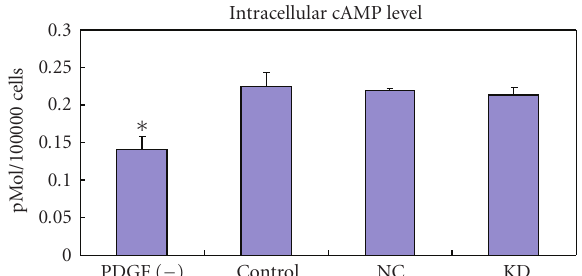
Figure 4: Knockdown of endogenous PDE4D does not a ff ect PDGF-induced cAMP level in VSMC. Bar graph illustrates PDGF- BB induced cAMP level in noninfected cells and cells infected with lentivirus particles carrying either PDE4D or nonsense shRNA. There were no significant di ff erences in cAMP level between cells infected with lentivrius carrying PDE4D shRNA and noninfected cells, cells infected with lentivirus particles carrying nonsense shRNA. Values represent means ± SEM from three separate experiments. ∗ P less than.05 versus